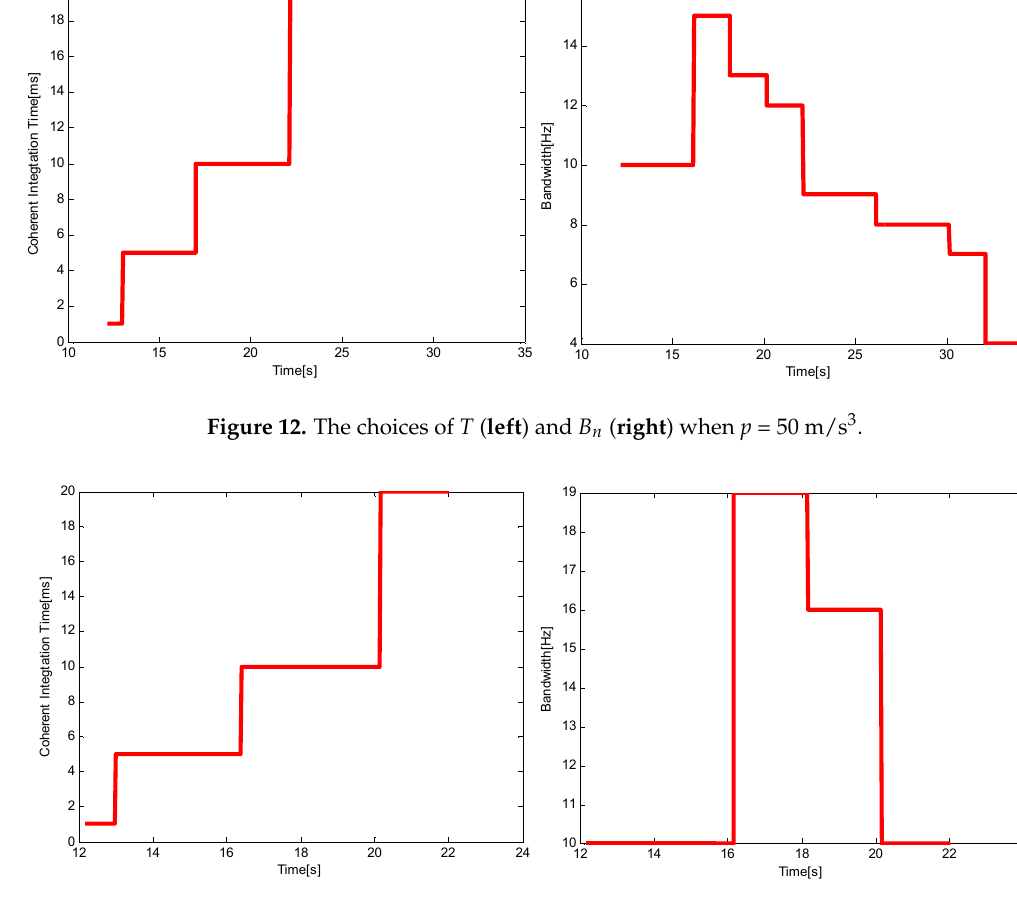
Figure 13. The choices of T ( left ) and B n ( right ) when p = 200 m/s 3 .